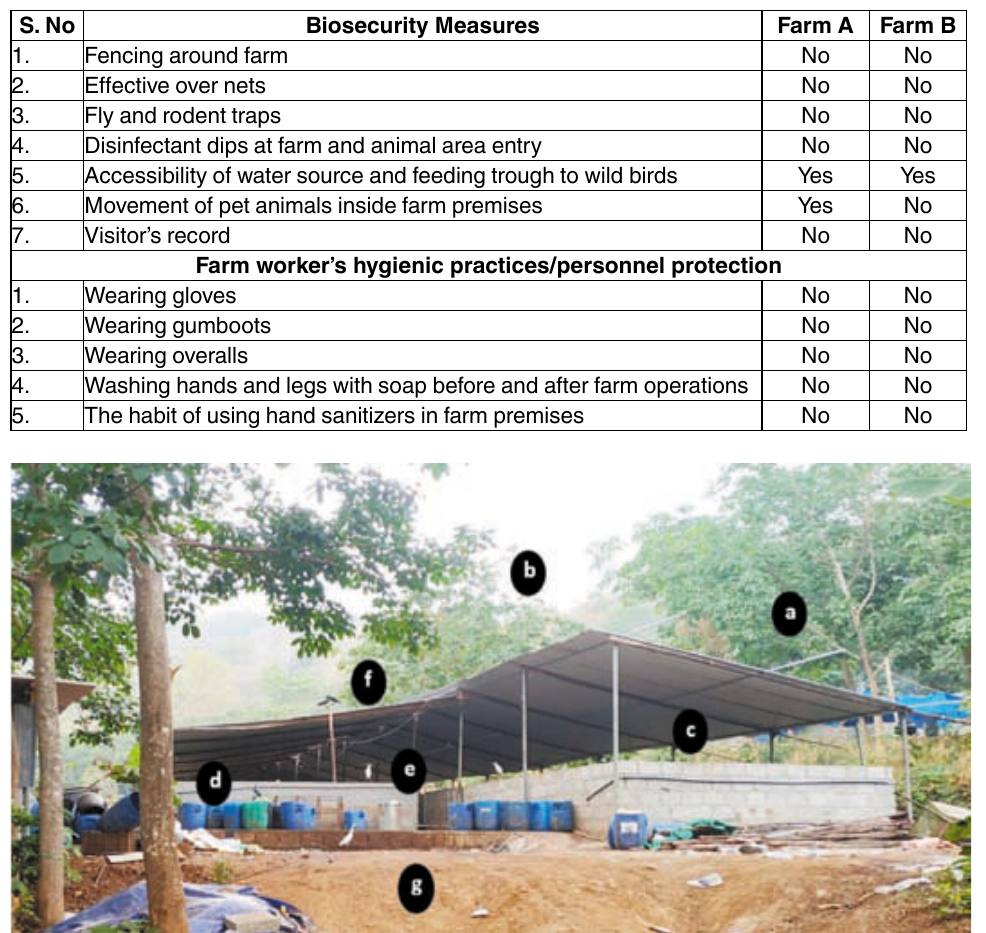
Fig. 2. Biosecurity breaches in pig farm: a) No fencing on the farm to prevent entry of unauthorized persons, stray and wild animals, b) No over nets to prevent the entry of wild birds c) No fly and rodent traps, d) Animal feeding and water trough were easily accessible to wild birds, e & f) Accessibility of animal area to wild birds such as crane and crow and g) Disinfection dips not installed at the entry